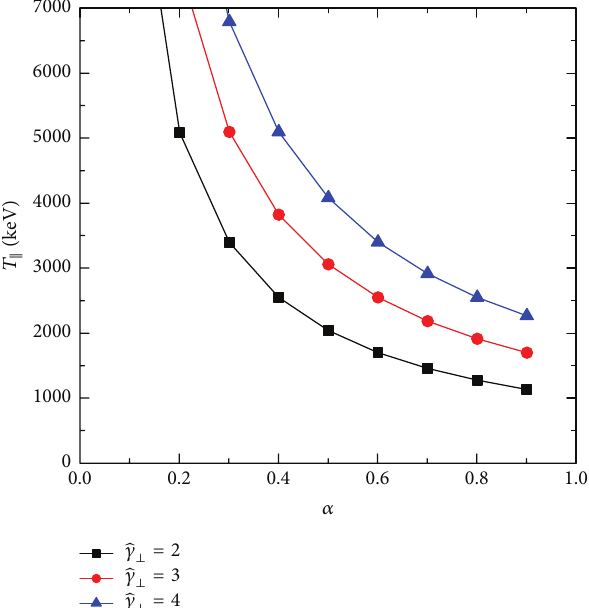
Figure 1: Variation of the normalized growth rate, (𝛿/𝜔 𝑝𝑒 )̂𝛾 1/2 ⊥ , according to (𝑐𝑘/𝜔 𝑝𝑒 )̂𝛾 1/2 ⊥ for difference 𝜂 in limits 𝛼 = 0.3 and ̂𝛾 = 3 . ⊥